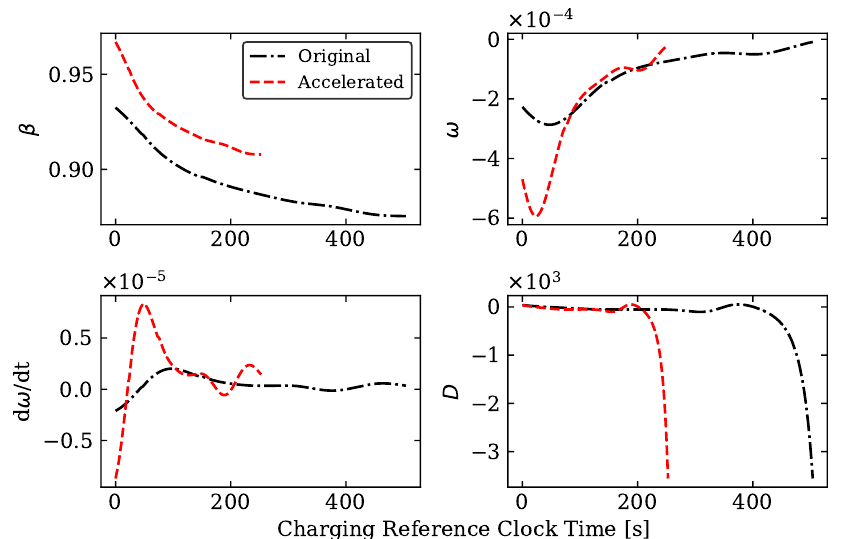
Figure 14. Comparison of discharging mode at the inlet location, phase 1.